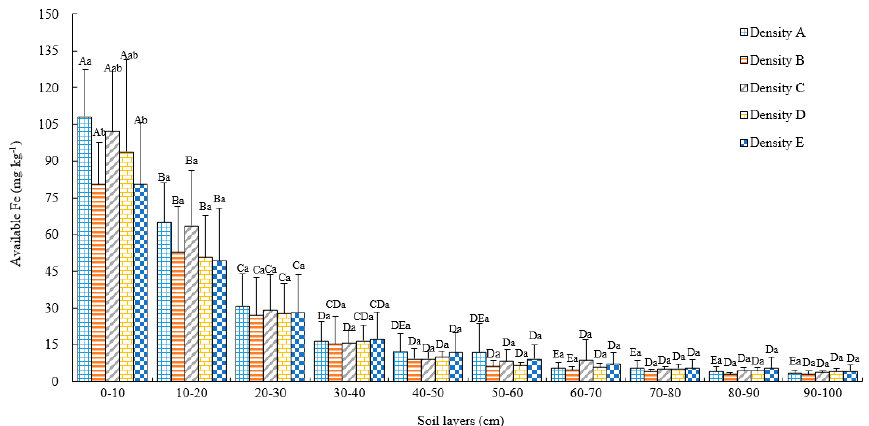
Figure 11. Soil available Fe in different layers under different stand densities (mg·kg − 1 ). Note: Different lowercase letters indicate significant differences among different densities at the 0.05 level, and different capital letters of the same density indicate significant differences among different soil layers at the 0.05 level.